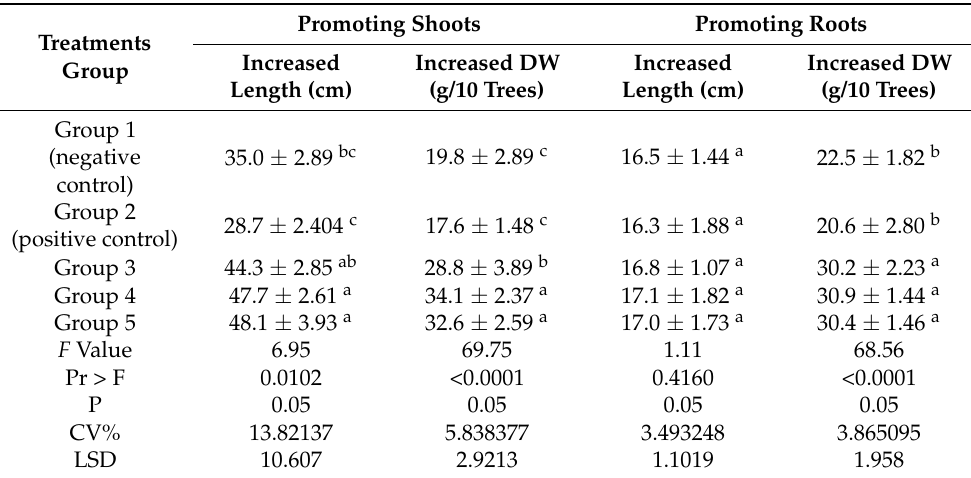
Table 3. The effect of Pseudomonas aeruginosa TUN03 on some plant promoting parameters of the coffee seedlings grown under greenhouse